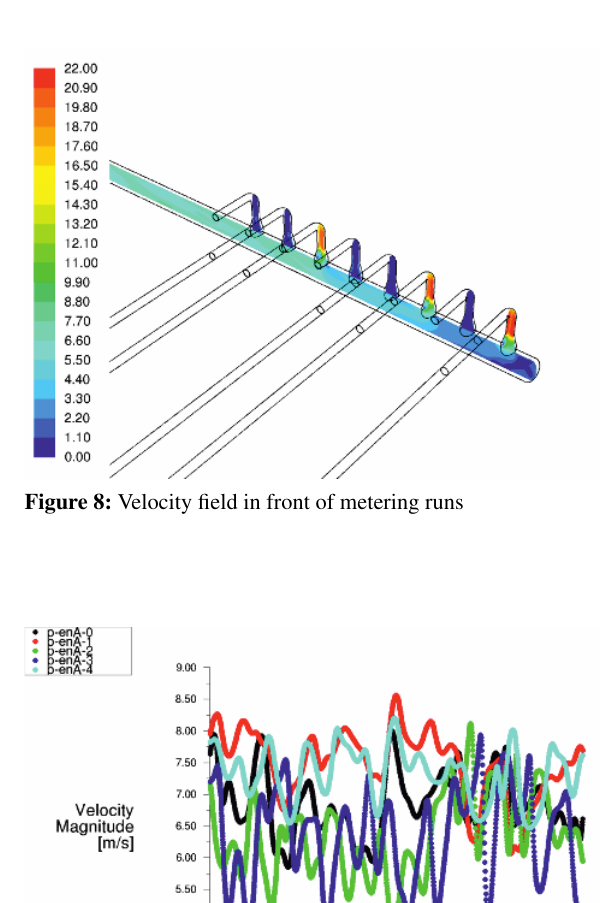
hind the T-junction region confirms the highly chaotic flow regime in this area.